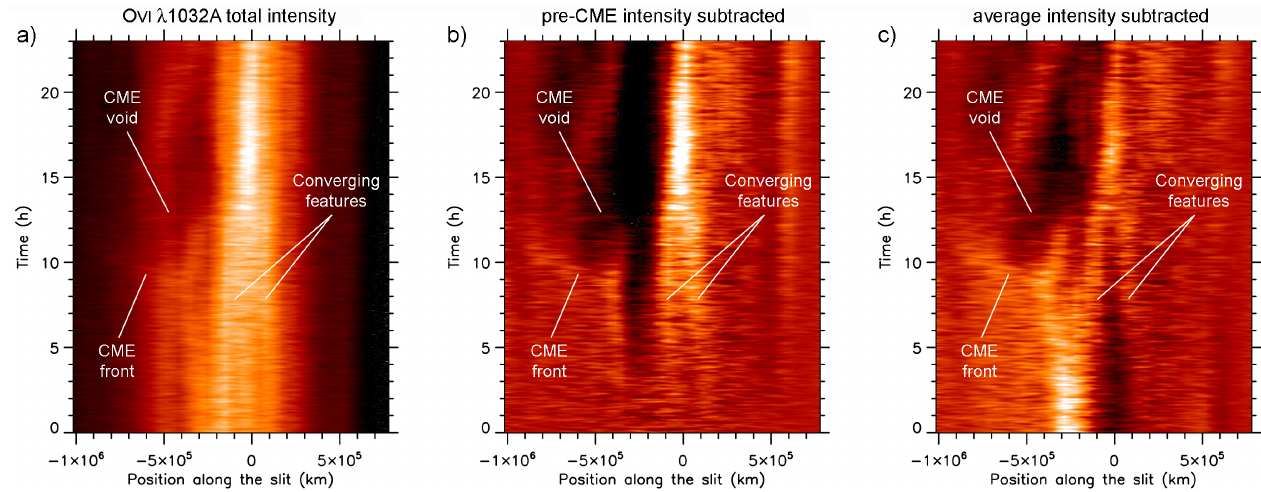
Fig. 5. The evolution of O VI λ 1032 ˚ A total intensity (a) and of the line intensity after the subtraction of the average pre-CME values (b) and of the average over the whole observation interval (c) . Time in the y axes is given starting on 10 December, 08:29UT, while the “0” in the x-axes marks the position of the slit center. Colors range from 0 (black) to 3 × 10 10 photcm − 2 s − 1 sr − 1 (white) in panel a and from − 6 × 10 9 (black) to + 6 × 10 9 photcm − 2 s − 1 sr − 1 (white) in panels (b) and